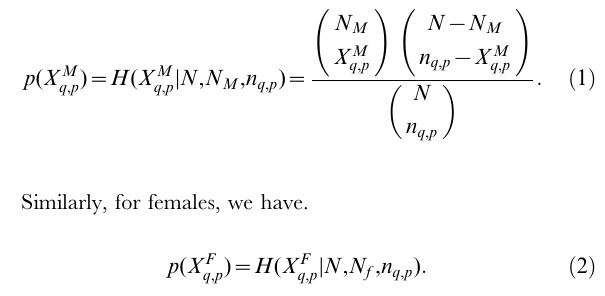
F . In Table 2 all the over-expressed and under-expressed answers of female and male candidates are reported, without conditioning on their party membership. In principle, the analysis could have